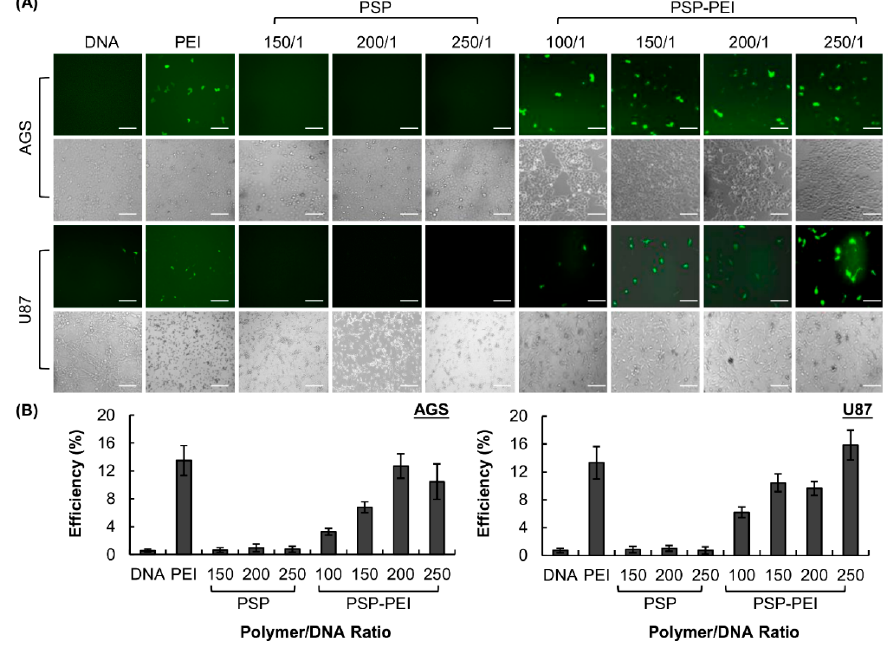
Figure 4. ( A ) Representative EGFP fluorescence images and phase-contrast images of AGS and U87